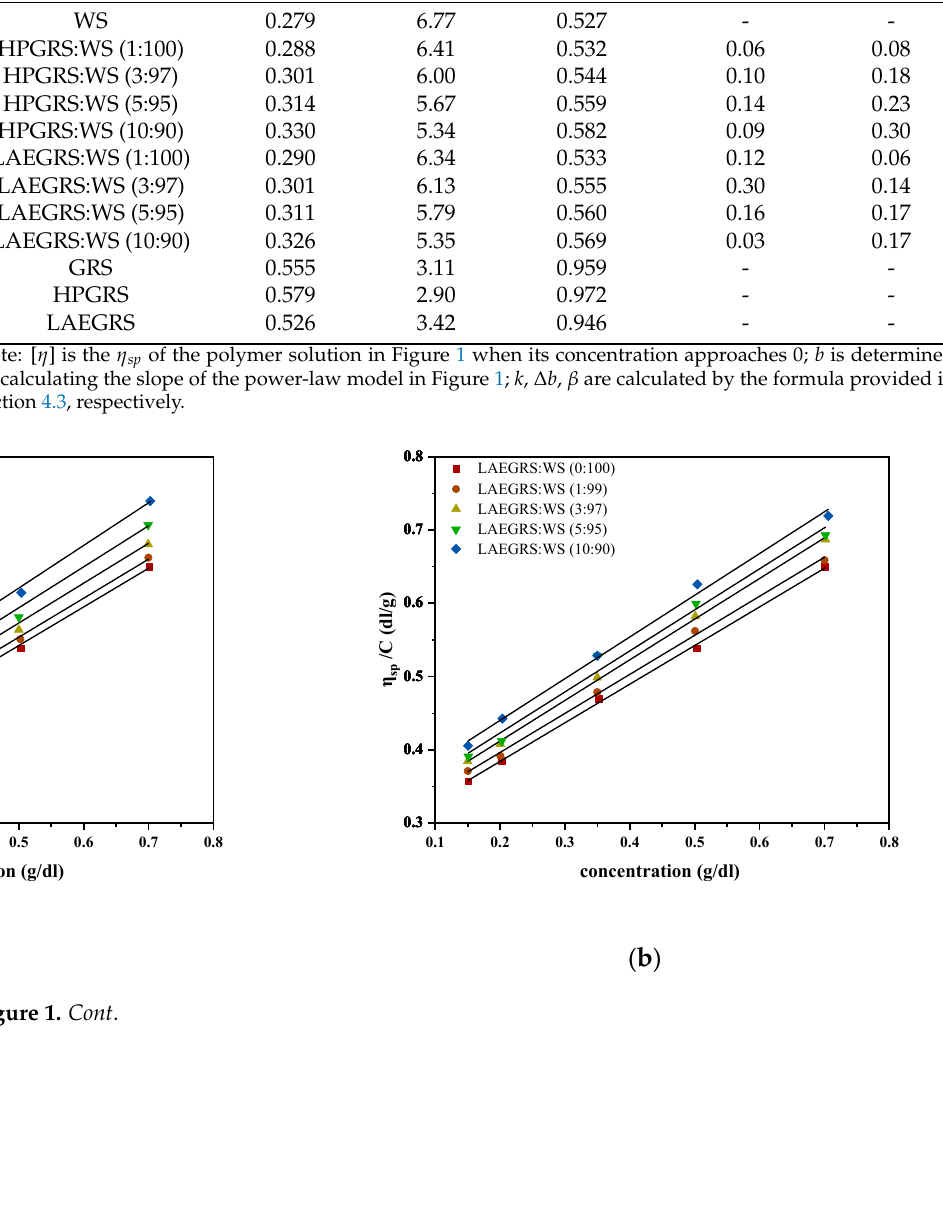
( c ) Figure 1. Reduced viscosity values of HPGRS-WS ( a ) at different ratios (HPGRS: WS = 1:99, 3:97, 5:95, 10:90); LAEGRS-WS ( b ) at different ratios (LAEGRS: WS = 1:99, 3:97, 5:95, 10:90); GRS, HPGRS, LAEGRS ( c ). 2.1.2. Huggins Constant The Huggins constant (k) is an essential parameter showing the aggregation of mac- romolecules, reflecting the molecular structure of polymer coils and the degree of coil ex- pansion [16,17]. The value of k for perfect solutions is in the range of 0.3 to 0.7, whereas for flexible macromolecules with expanding shapes in a suitable solvent, the magnitude of this parameter is in the range of 0.2 to 0.4. For dilute solution, when the k value is higher than 1, it would bolster the formation of aggregates. As shown in Table 1, in deionized water at 25 °C, the k value of both types of mixed starches was greater than 1, which was related to the recombination of starch chains to form insoluble aggregates [19]. Among them, the k value of single HPGRS and LAEGRS were 2.90 and 3.42, respectively, which were lower than that of single WS (6.77). Compared to the two modified starches, WS has the higher amylose content and easier to form an ordered aggregated structure. Thus, with the increase of the WS component replaced by HPGRS and LAEGRS, the k value of the two mixed starchy species shows a downward trend. The k value of the mixed starch with